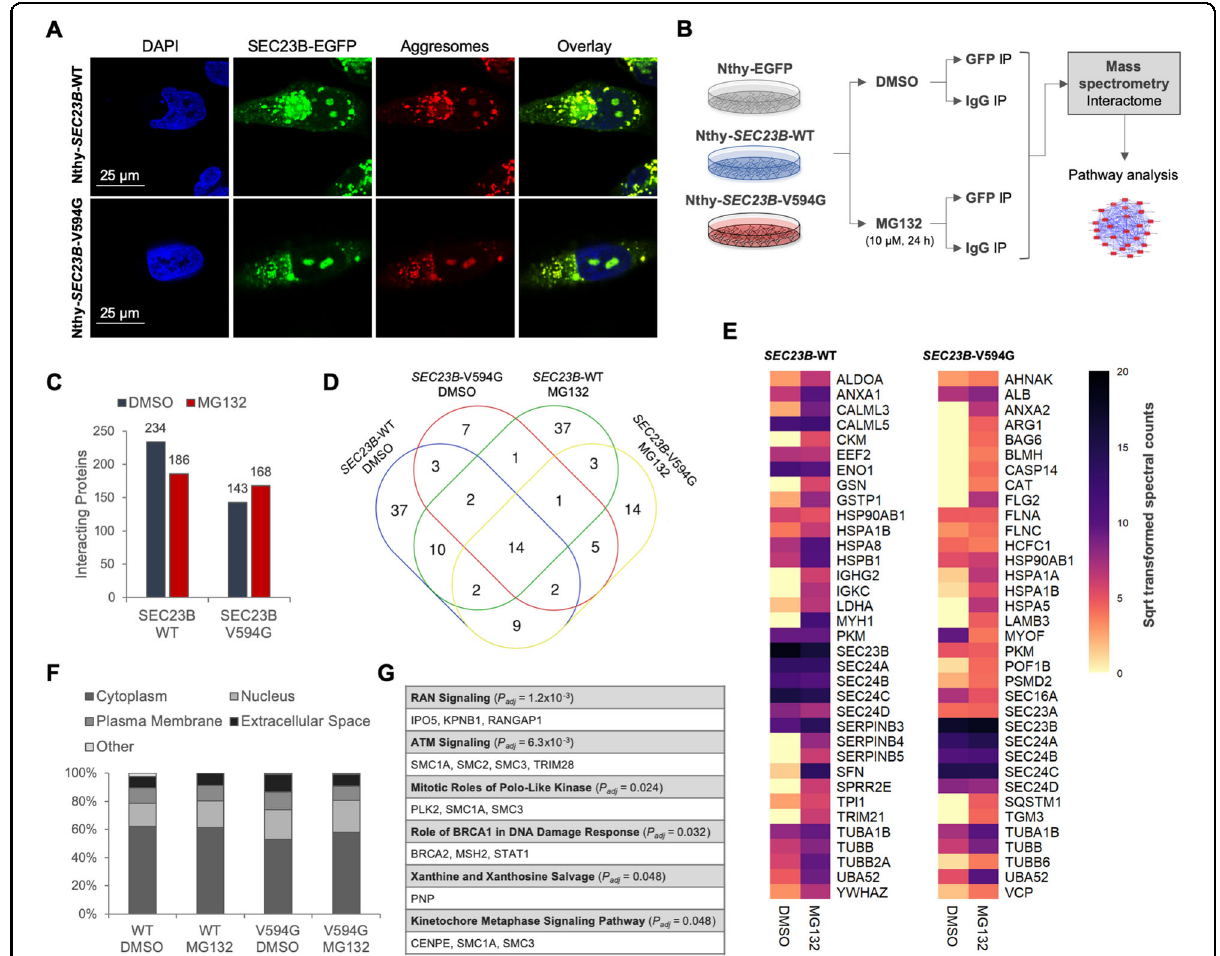
Fig. 4 Global overview of the SEC23B interactome. A Immuno fl uorescence staining of stably transduced Nthy-ori 3-1 thyroid cells for aggresomes. Blue, DAPI; green, SEC23B-EGFP or EGFP. Scale bars, 25 µm. B Experimental design of the mass spectrometry experiment with and without MG132 treatment. IgG immunoglobulin, IP immunoprecipitation. C Global number of interacting partners in Nthy- SEC23B -WT and Nthy- SEC23B -V594G cells with and without MG132 treatment. Only protein interactants with spectral count ratios ≥ 2 relative to the IgG and Nthy-EGFP immunoprecipitations (negative controls) are depicted. D Overlapping and unique interacting partners between untreated and MG132-treated Nthy- SEC23B -WT and Nthy- SEC23B -V594G cells. Only proteins with spectral counts ≥ 10 are included in this Venn diagram. Table S2 includes the complete list of interacting proteins. E Heatmaps of the top 35 interacting proteins based on spectral counts in wild-type Nthy- SEC23B -WT and mutant Nthy- SEC23B -V594G cells. COPII component and related proteins (SEC23B, SEC23A, SEC24A-D, SEC31A, SEC23IP, SEC16A) serve as positive controls. Table S2 includes the complete list of interacting proteins. Sqrt square root. F Subcellular localization analysis using Ingenuity Pathway Analysis (IPA) indicates that a subset (16 – 23%) of the SEC23B-interacting proteins is predicted to reside in the nucleus. G Pathway analysis of SEC23B-interacting proteins predicted to reside in the